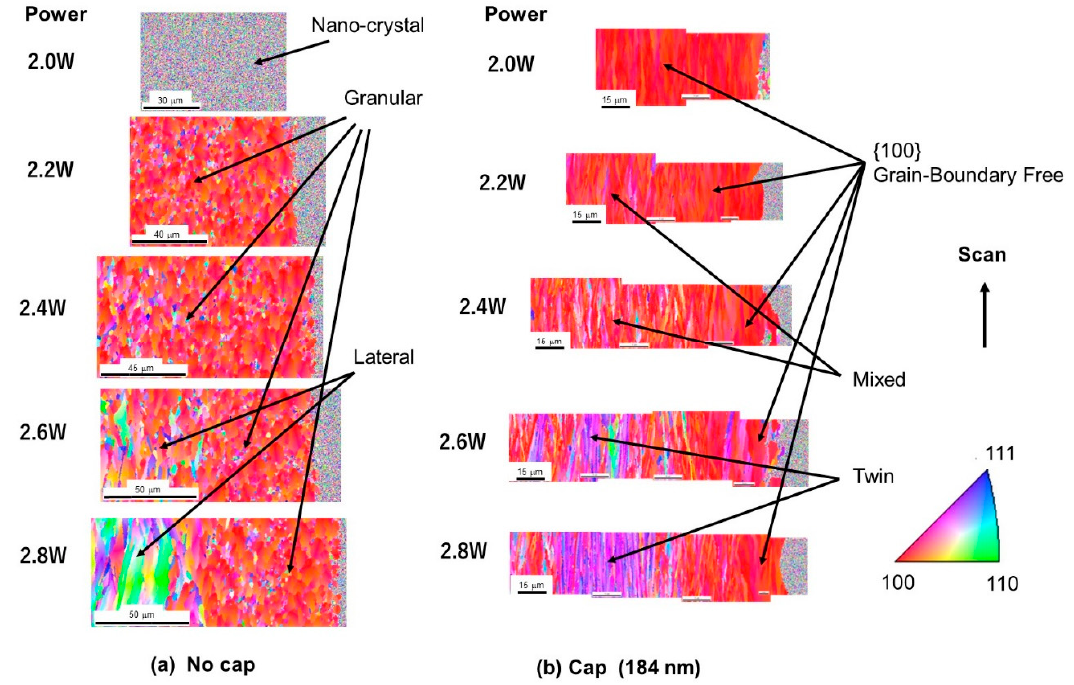
Figure 20. Effects of SiO 2 cap to grow {100}-oriented films. EBSD IPF ND maps are shown as a function of laser power; ( a ) without cap, and ( b ) with cap of 184 nm. In (a), natural oxide on the surface was etched off by the buffered HF solution just before the crystallization. The laser scan velocity was 15 mm/s. After Sasaki et al. [54].